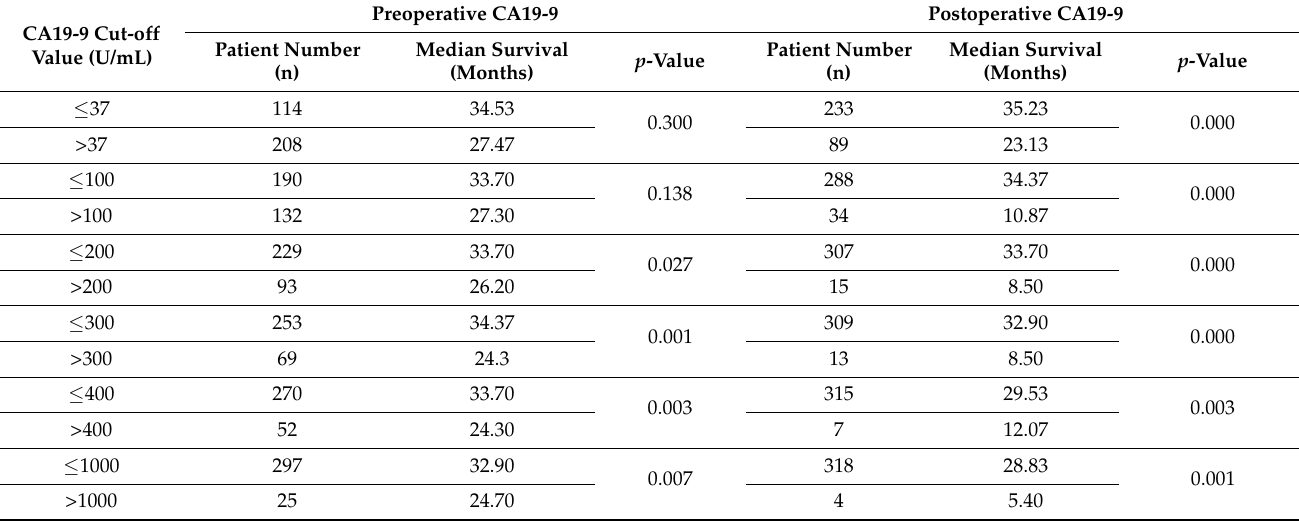
Table 2. Difference of overall survival in two groups divided on the basis of CA19-9 cutoff